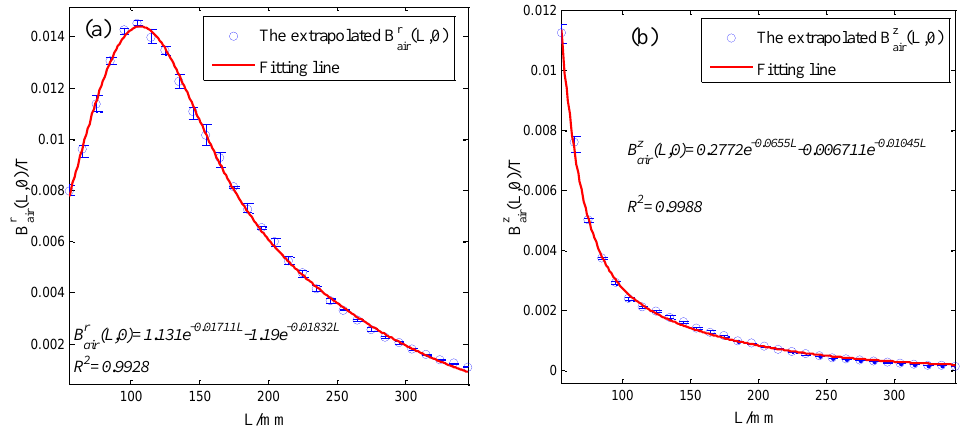
Figure 12. The extrapolated radial ( a ) and axial ( b ) magnetic flux densities at the interface and the corresponding fitting lines.